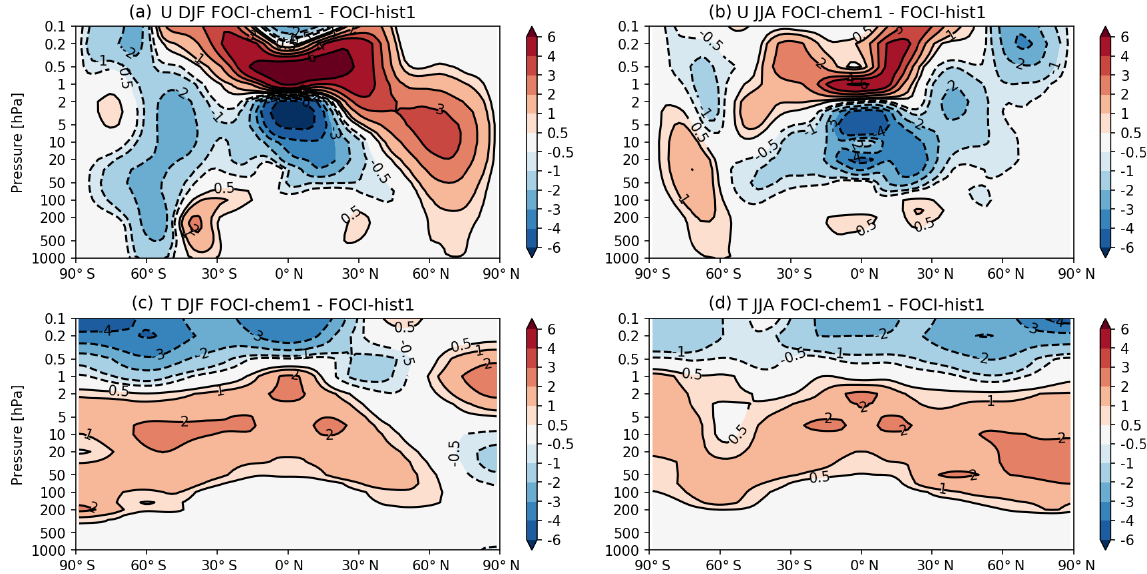
Figure 9. Differences between the FOCI-chem1 and the FOCI-hist1 simulations averaged from 1980 to 2013 in (a) DJF zonal mean zonal wind and (b) JJA zonal mean zonal wind in ms − 1 , (c) DJF zonal mean temperature and (d) JJA zonal mean temperature in K. Please note the non-linear color bars.